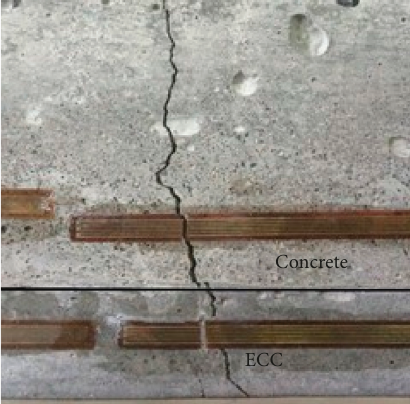
Figure 10: Cracking pattern of the bonded composite